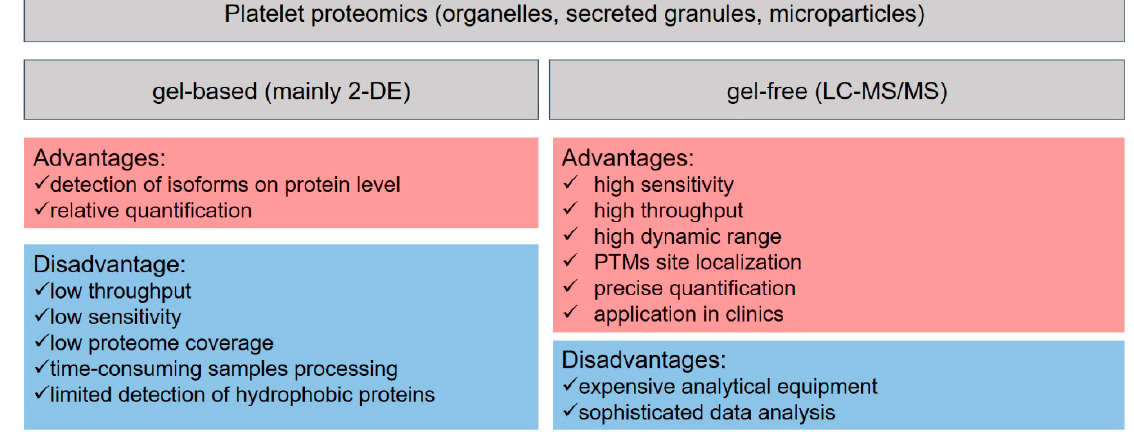
Figure 4. Advantages and limitations of basic methods in proteomics.